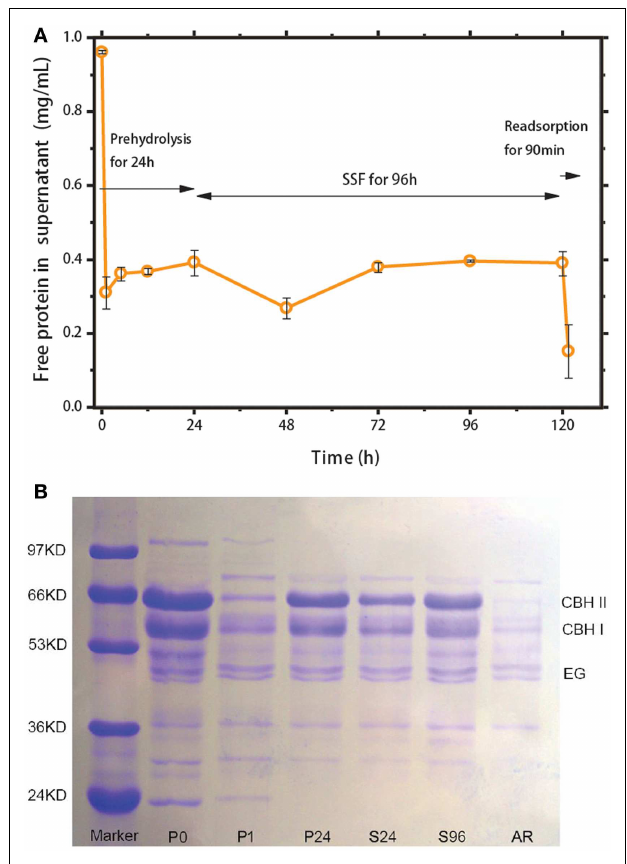
FIGURE 4 | (A) Tracking of cellulase adsorption during prehydrolysis, SSF, and re-adsorption. (B) SDS-PAGE analysis of cellulase in supernatant during prehydrolysis for 0 (P0), 1 (P1), and 24h (P24); SSF for 24h (S24) and 96h (S96); and after re-adsorption (AR).